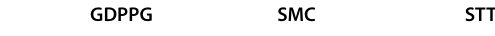
Table 2 Correlation matrix. Source: Software of E-views 10 output